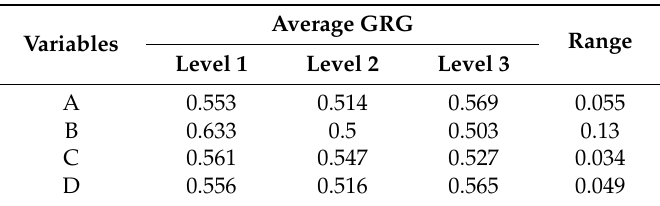
Table 5. Calculation results of average